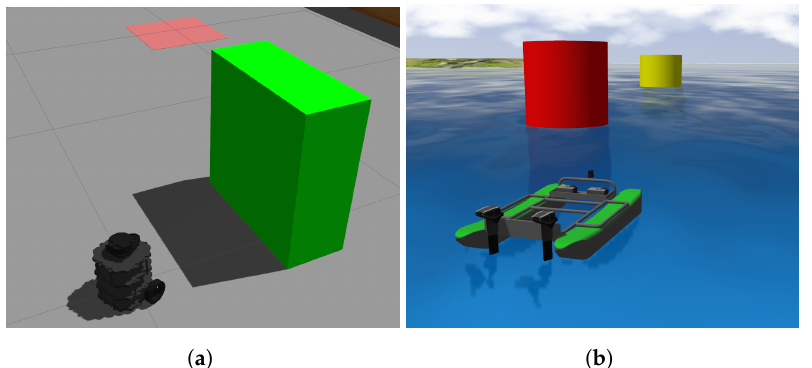
Figure 6. USV and UGV vehicles used in cross-domain DRL training. ( a ) Turtlebot in simulation. ( b ) BREAM in